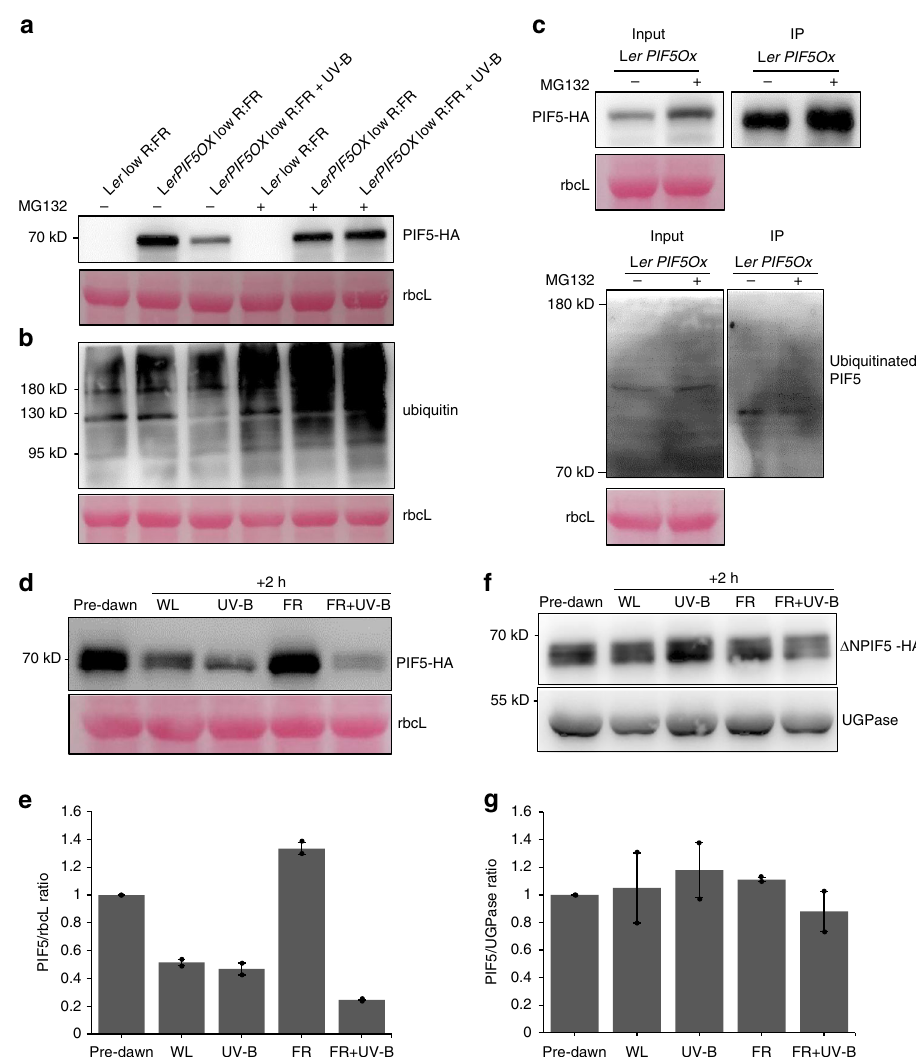
Fig. 4 UV-B-mediated PIF5 degradation occurs via the proteasome system and requires the APB domain of PIF5. a MG132 inhibits PIF5 protein degradation in L erPIF5Ox . Plants were grown for 10 days in 16 h light/8 h dark cycles before being transferred to ½ strength MS liquid medium containing 0.1% DMSO ± 50 uM MG132 for 16 h. Plants were transferred at dawn to low R:FR ± UV-B for 40 min. PIF5-HA was detected with an anti-HA antibody. L er was used as negative control and ponceau staining of the Rubisco large subunit (rbcL) was used as loading control. b Western blot of protein samples from ( a ) probed with an anti-ubiquitin antibody. c Co-IP assay showing PIF5 ubiquitination. Seedlings were grown as in ( a ). Total protein extracts were immunoprecipitated from low FR + UV-B 30 min treated samples with anti-HA beads and immunoblots probed with anti-HA or anti-Ubiquitin antibodies. Ponceau stained Rubisco large subunit (rbcL) was used as a loading control. d Western blot of PIF5 protein abundance in 35S:PIF5-HA plants. Seedlings were grown for 10 days in16 h light/8 h dark cycles before transfer at dawn to high R:FR ± UV-B for 2 h. PIF5 was detected with an anti-HA antibody. UGPase was used as loading control. e Quanti fi cation of PIF5/rbcL ratio in two biological repeats of ( d ). Bars represent s.e.m. f Western blot of PIF5 protein abundance in 35S: Δ N.PIF5 lines containing a deletion of the fi rst 68 amino acids of the PIF5 protein. Blots were performed as in ( c ). g Quanti fi cation of Δ N.PIF5/UGPase ratio in two biological repeats of ( f ). Bars represent s.e.m. Source data are provided as a source data fi input controls (Fig. 5a). PHYB was used as a positive control for central repressor of photomorphogenesis and accumulates in the the immunoprecipitation of PIF5 complexes and was clearly detected in IP samples (Fig. 5a). Interestingly, PHYB was observed as two bands of different molecular weights. Their identity was con fi rmed by comparison of input controls with a phyB mutant in which neither band was detected (Supplementary Fig. 6a). Immunoprecipitated PHYB was a lower molecular weight, suggesting that phyB-PIF5 interaction results in mod- i fi cation of the PHYB protein (Fig. 5a).